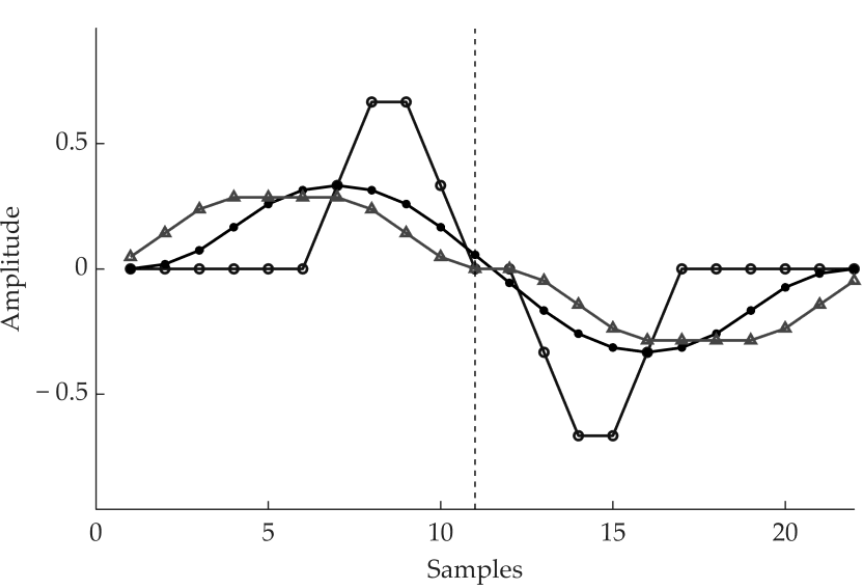
Figure 4. Example of the impulsive response of three among the derivative filters we